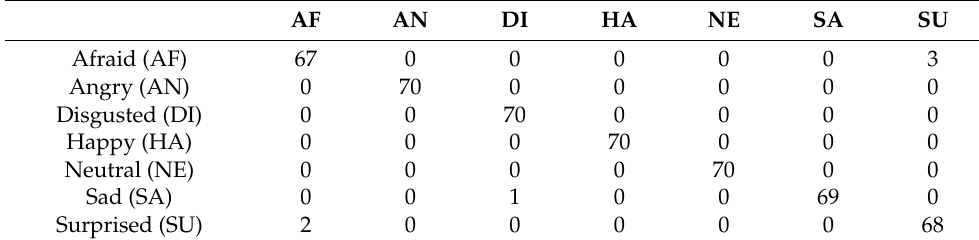
Table 4. Classification of each emotion class of KDEF dataset.